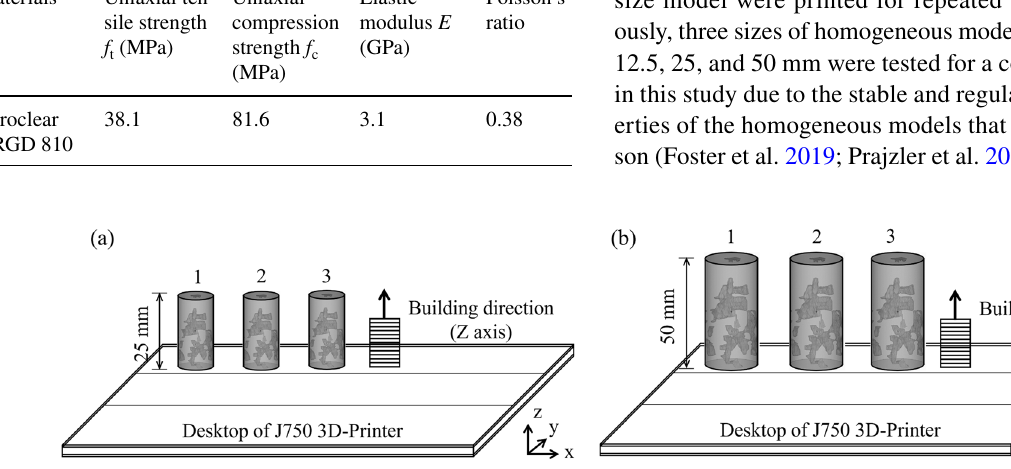
Fig. 4 Diagramatic representation of the printing process, showing the print direction and print batch. a Model height = 25 mm; b Model height = 50